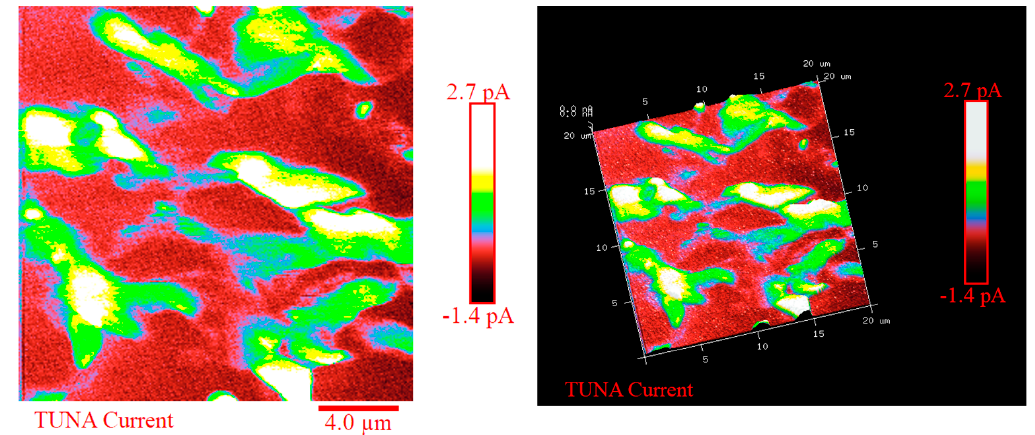
Figure 9. TUNA Current pictures (from left to right: 2D and 3D shapes) of the R1.8%G fracture surface.